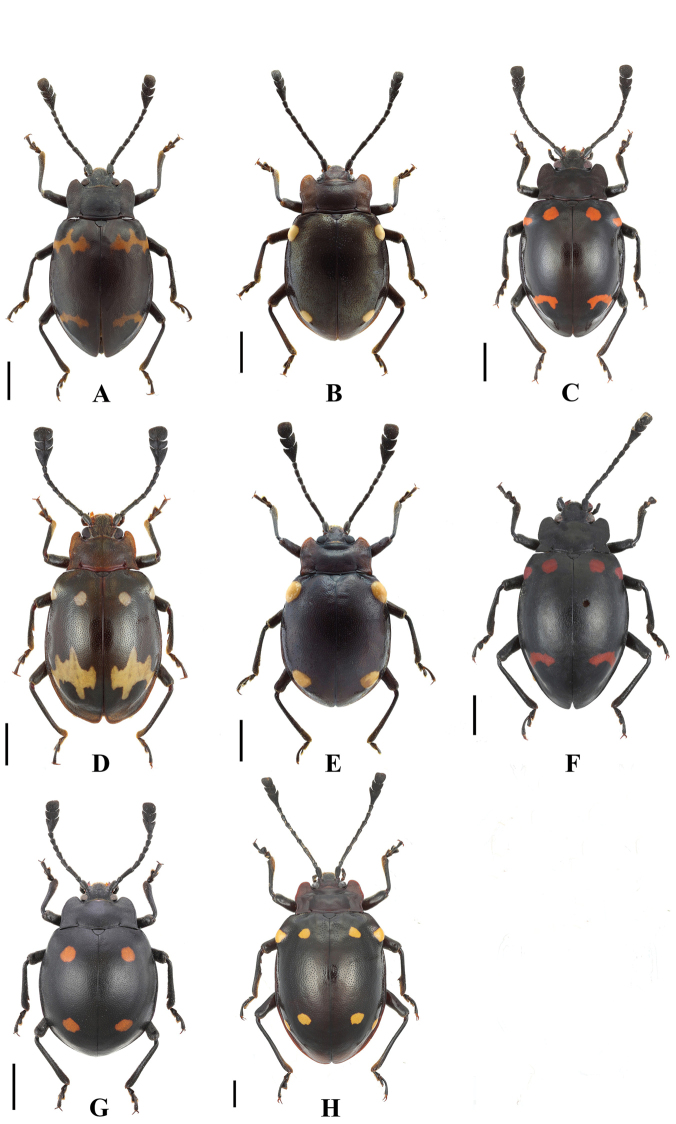
Habitus of Sinocymbachus spp. (males) AS.
angustefasciatusBS.
bimaculatusCS.
decorusDS.
excisipesES.
humerosusFS.
luteomaculatusGS.
parvimaculatusHS.
quadrimaculatus. Scale bar: 2 mm.